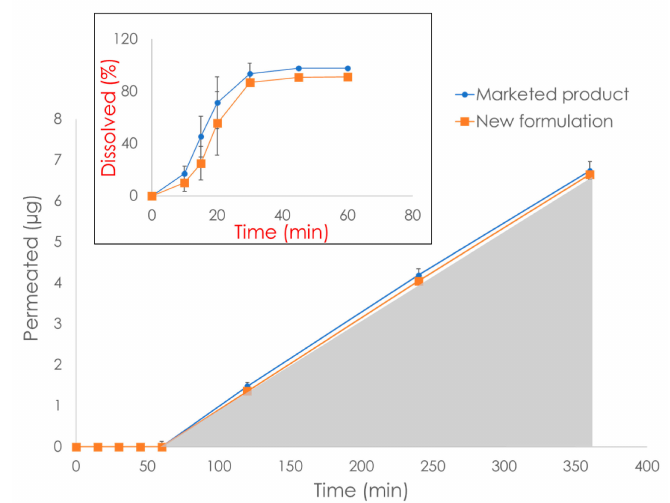
Figure 15. Example of dissolution/permeation results obtained with Dissoflux with PermeaPad cartridges. The in vitro AUC 0–6 h (gray zone) was used to evaluate the bioequivalence of two solid dosage forms (marketed product and new formulation, personal communication from